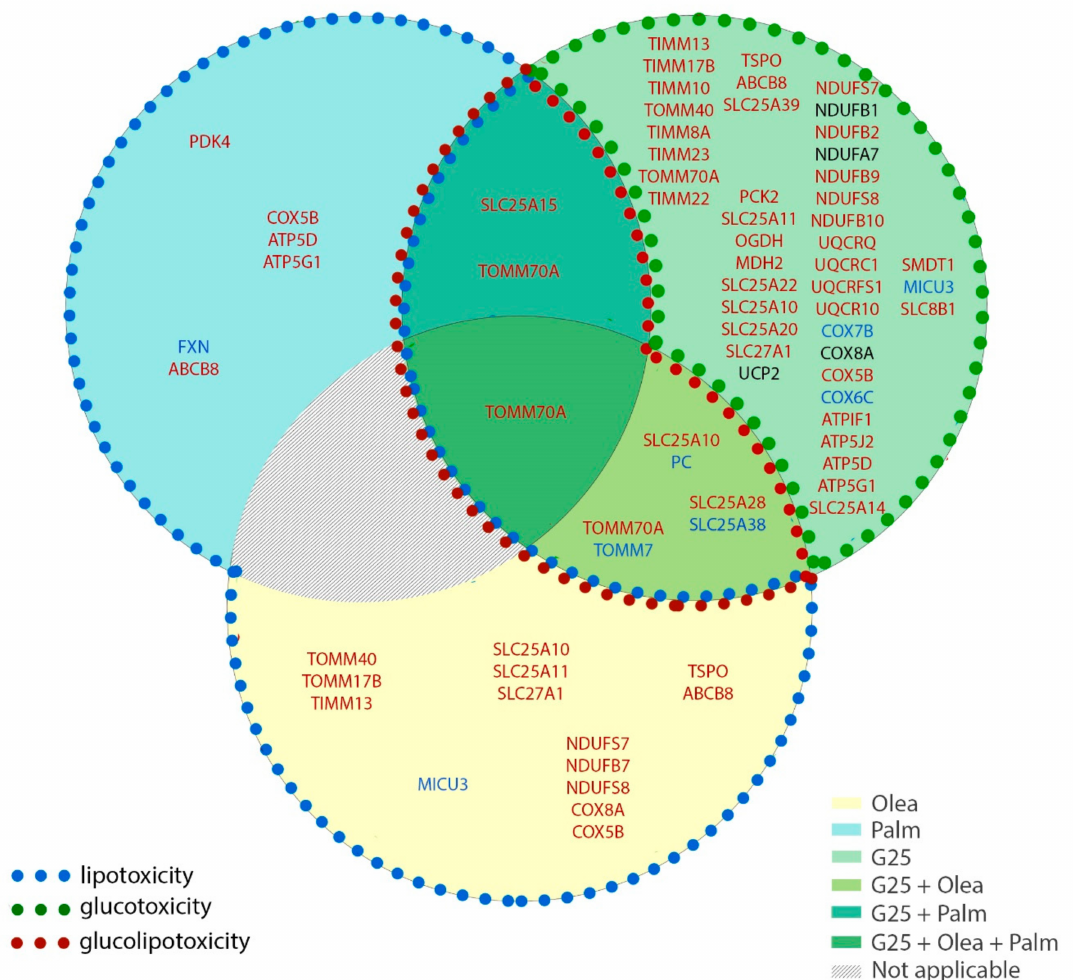
Figure 7. Stress-specific mitochondrial transcriptome profile of human islets upon lipotoxic, glucotoxic, and glucolipotoxic conditions. Isolated human islets were exposed for 3 days to di ff erent culture conditions: 25 mM glucose (G25) in the green circle, 0.4 mM oleate (Olea) in the yellow circle, and 0.4 mM palmitate (Palm) in the blue circle. The superimposition of the circles represents the mix of the corresponding conditions: G25 + Olea in the superimposition of the green and yellow circles, G25 + Palm in the superimposition of the green and blue circles, and G25 + Palm + Olea in the superimposition of the three conditions. The condition corresponding to Palm + Olea at G5.5 was not tested (not applicable). The circle sections contain the genes whose expression is modified upon that specific stress condition. Colors reflect positive (red), negative (blue) or variable (black) changes in mRNA. Significant changes were considered when two or more independent islet batches (donors) exhibited down or upregulation with a log 2 FC threshold of 0.5 associated with one or more adjusted p < 0.05.